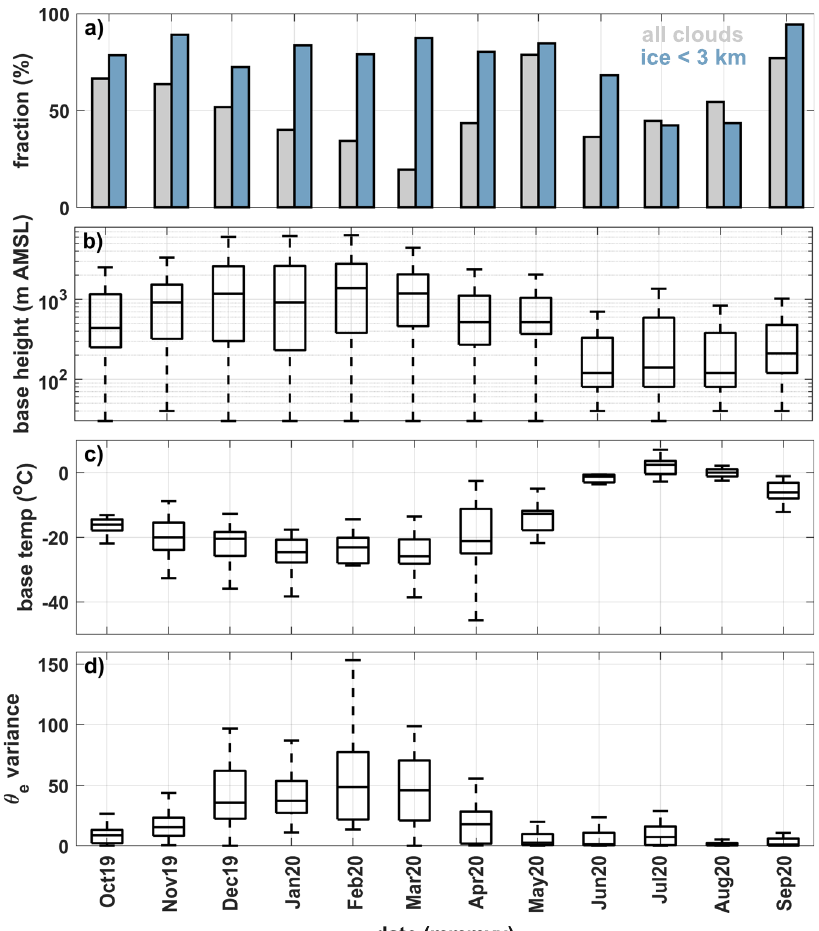
Fig. 6 Annual cycle of clouds and atmospheric strati fi cation during the Multidisciplinary drifting Observatory for the Study of Arctic Climate (MOSAiC). Data include monthly averaged: a cloud fraction and cloud ice fractional occurrence below 3 km AMSL, b cloud-base height, c cloud-base temperature (temp), and d vertical variance of sub-cloud equivalent potential temperature ( θ e ). For b – d , the central mark indicates the median, and the bottom and top edges of the box indicate the 25th and 75th percentiles, respectively. The whiskers extend to the most extreme data points not considered